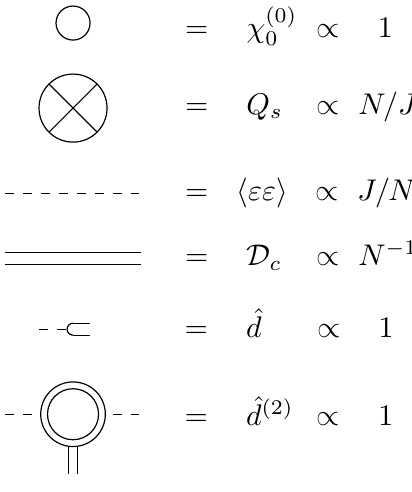
Figure 1 . Diagrammatic expressions for the Feynman